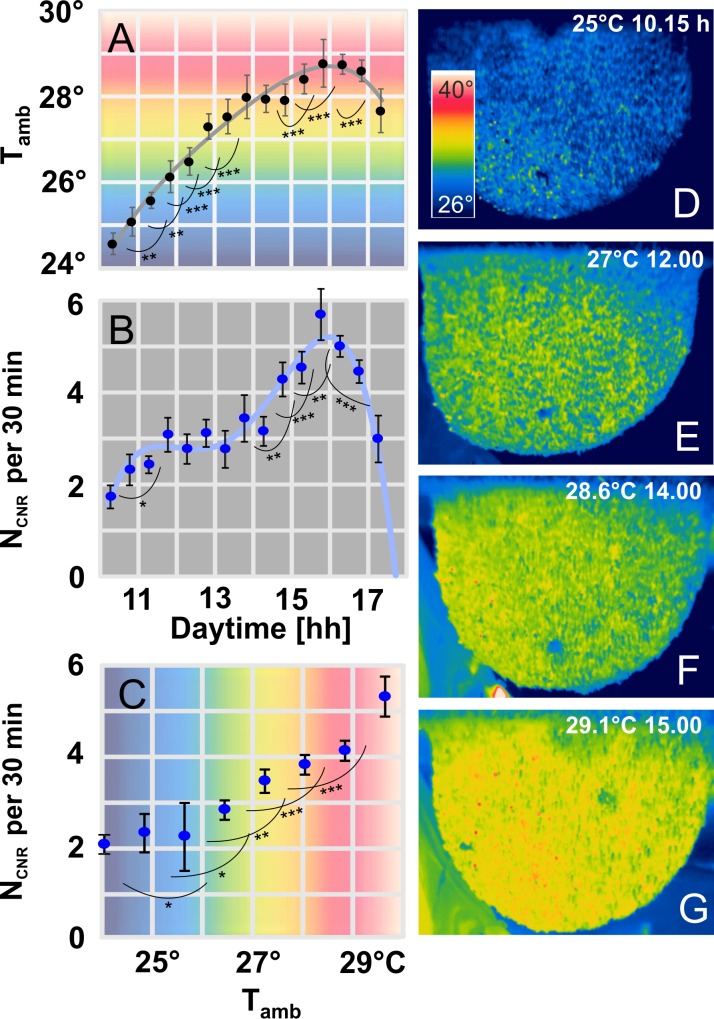
The occurrence of CNRs.(A) Plot of ambient temperature in °C (ordinate: Tamb) over daytime in hours (abscissa). Pooled data from “nest 02” assessed in steps of 30 min (n = 209 measurements; nexp = 11 experiments; Nov. 2010, Chitwan, Nepal); grey line, regression of arithmetical means: R2 = 0.9785. (B-C) Occurrence of CNRs (total NCNR = 208) per 30 min over daytime (panel B: R2 = 0.9631) and Tamb (panel C: R2 = 0.9754). Stars give significant differences between adjacent pairs of data (*, P < 0.05; **, P < 0.01; ***, P < 0.001; t-test). Full circles, means; vertical bars, mean errors. The background colours symbolize the temperature gradient from cool (blue) to warm (red). (D-G) IR images at different Tamb and day times (see white text insets); scale bar (inset D), temperature range in °C.